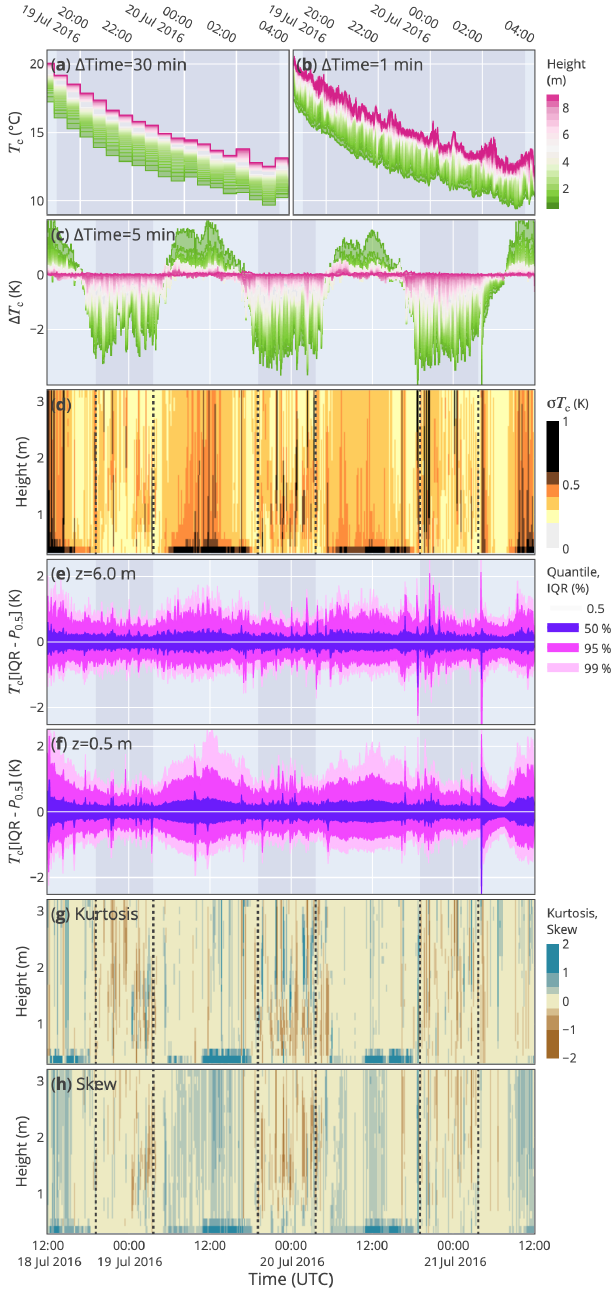
Figure 5. Shown against time are (a, b) fibre-optic cable tempera- ture ( T c ) for a selected night and 30 and 1min averaging, respec- tively, (c) the T c gradient relative to the top of the profile, (d) the T c variance against height, (e, f ) the interquartile range (IQR) relative to the median ( P 0 . 5 ) for 6.0 and 0.5m above ground, respectively, (g) the kurtosis and skewness of T c against height,